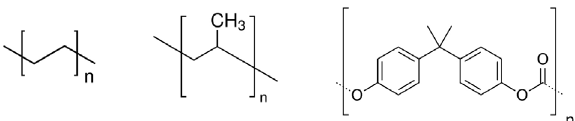
Figure 1. Structural formula of PE, PP and